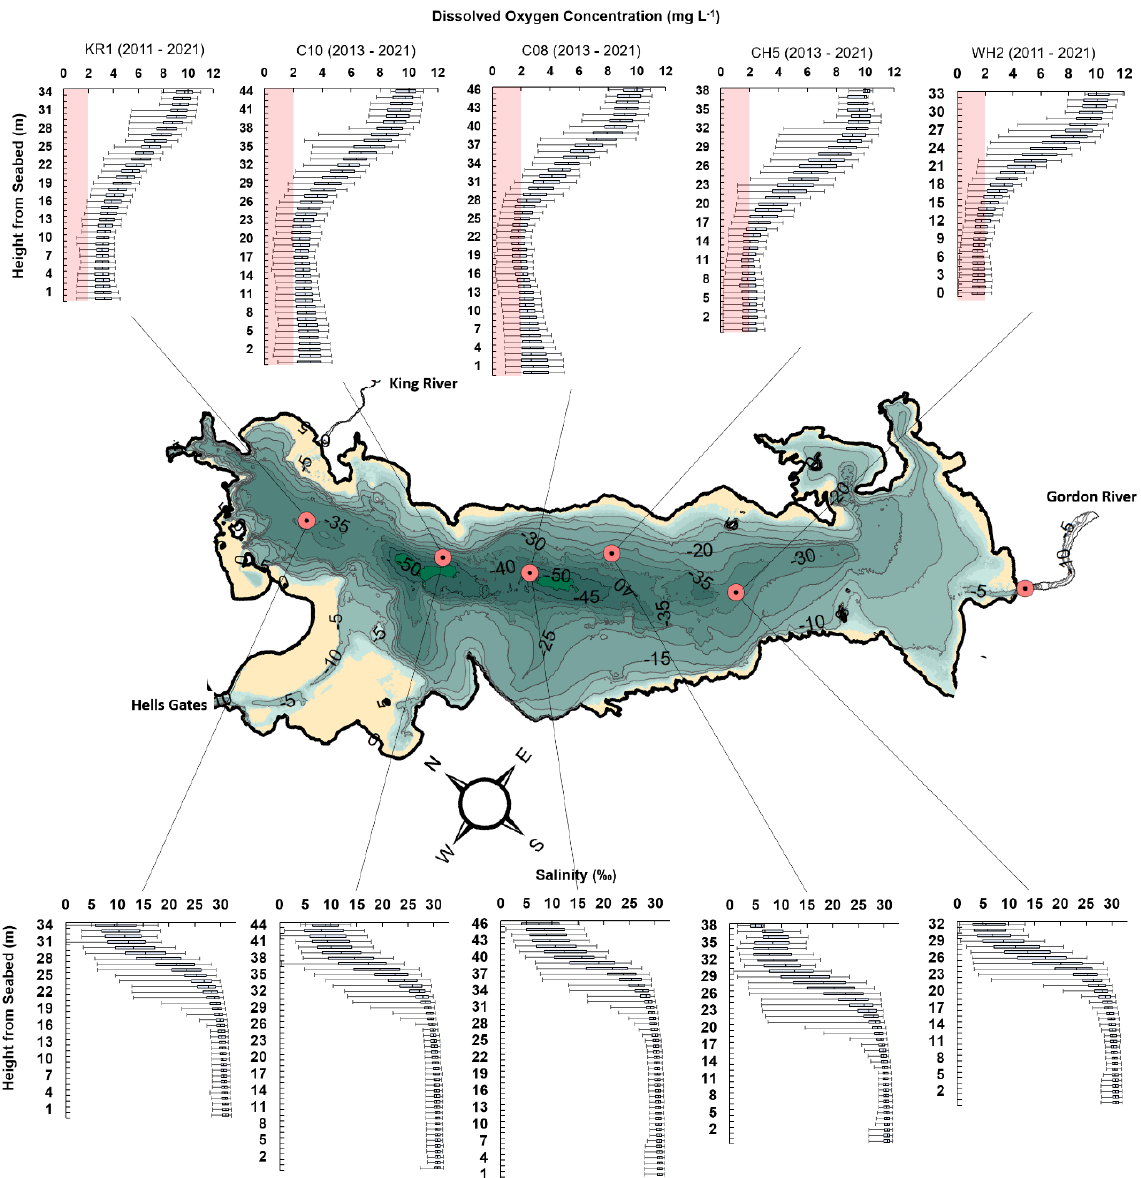
Figure 5. Box plots of dissolved oxygen concentration (mgL − 1 ) and salinity monthly profiles. Extent of dataset for each site is specified above the plots. Note vertical resolution is 1m and references height from the seabed. Hypoxic ( < 2mg L − 1 ) conditions are highlighted in